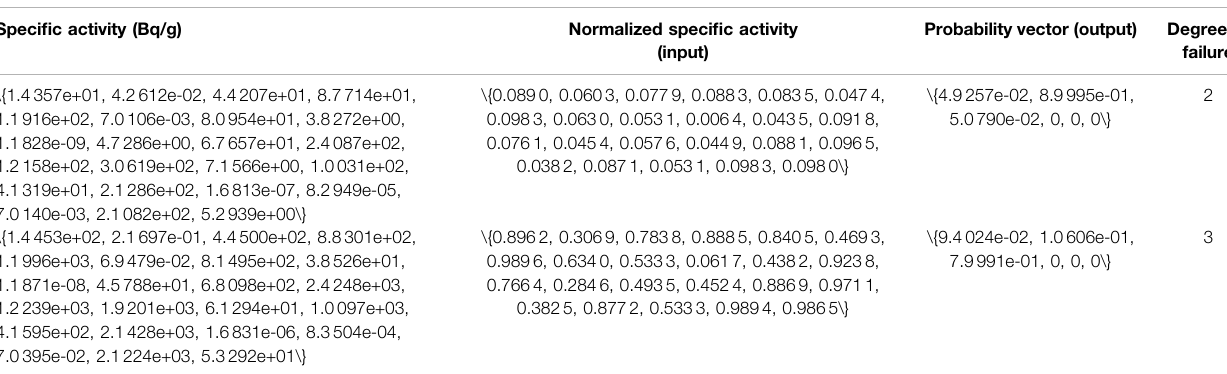
TABLE 1 | Typical samples of the input and output of the neural